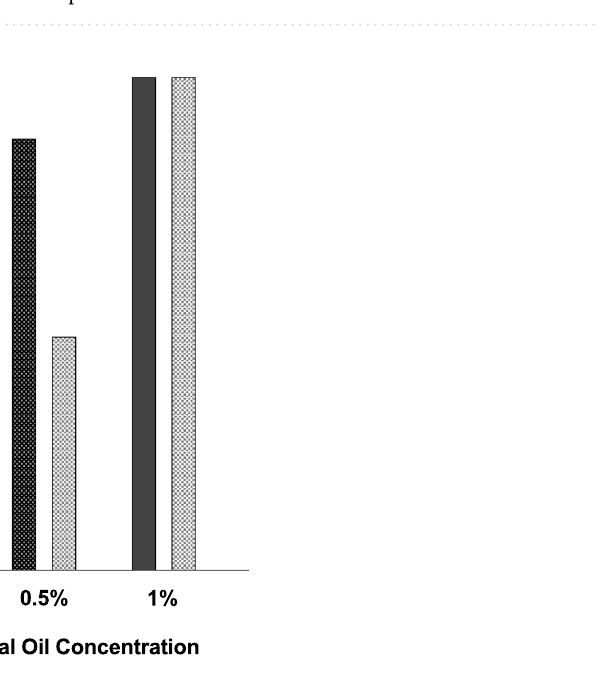
Figure 3. Mean repellency (%) over time of Ixodes scapularis nymphs exposed to balsam fir essential oil (EO) at different concentrations (1–8% v/v). N = 30 per treatment.